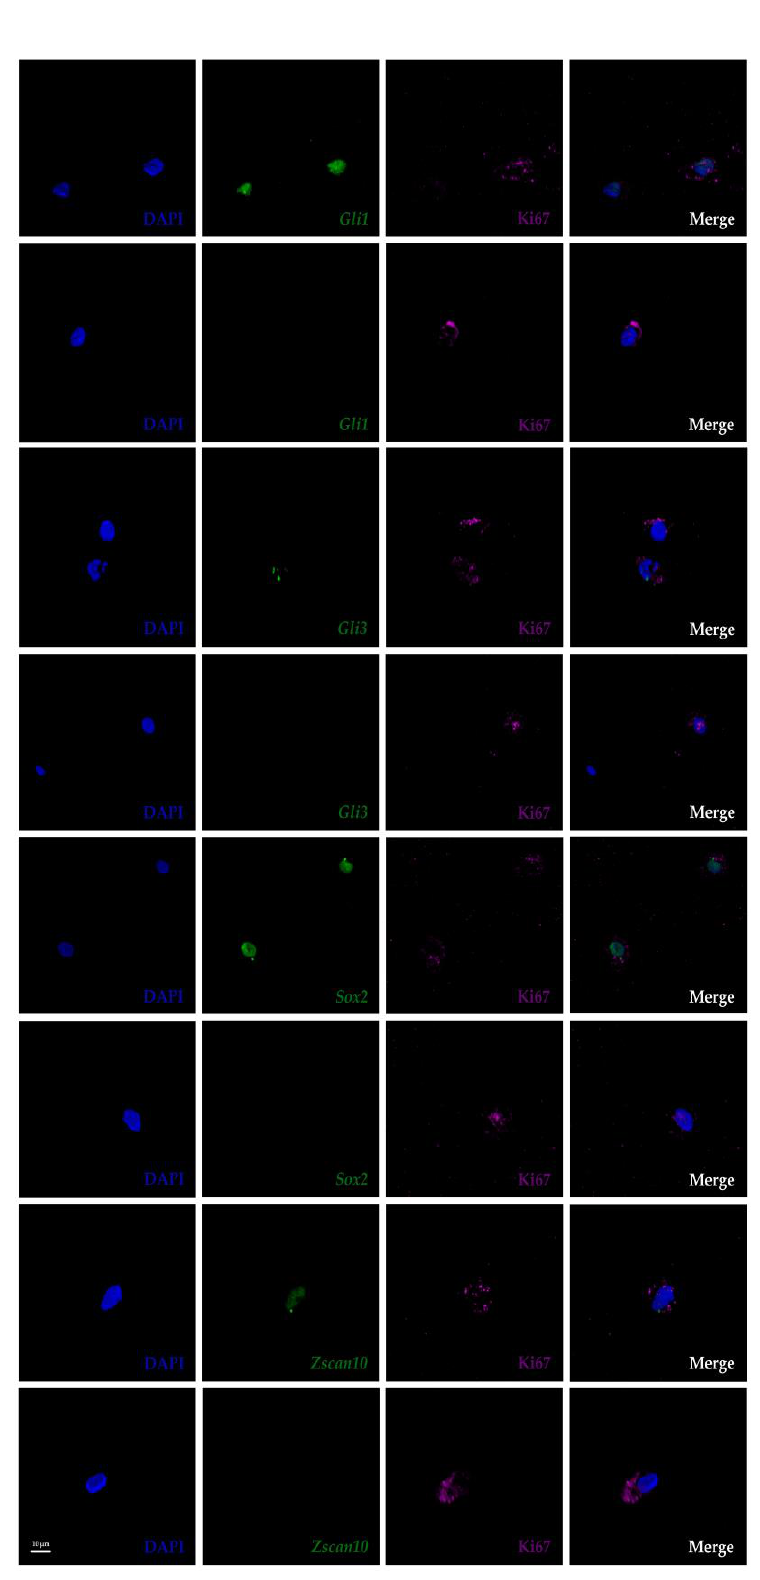
Figure 4. Combined FL-RISH and immunohistochemistry (IHC) showing RNA transcripts (green) and Ki67 protein (magenta) in cells of the nucleus pulposus of a mature bovine IVD. DAPI (blue) labels the nucleus. Ki67 indicates active phases of the cell cycle, or cells that are not in G0). Images shown at 63 × magnification and zoom factor of three. Glioma-associated oncogene 1 (Gli1) ; Glioma-associated oncogene 3 (Gli3) ; Sex determining region Y-box 2 (Sox2 ); Zinc finger and SCAN ( SRE-ZBP, CTfin51, AW-1 and Number 18 cDNA) domain containing transcription factor 10 (Zscan10). Scale bar reflects 10 µm.